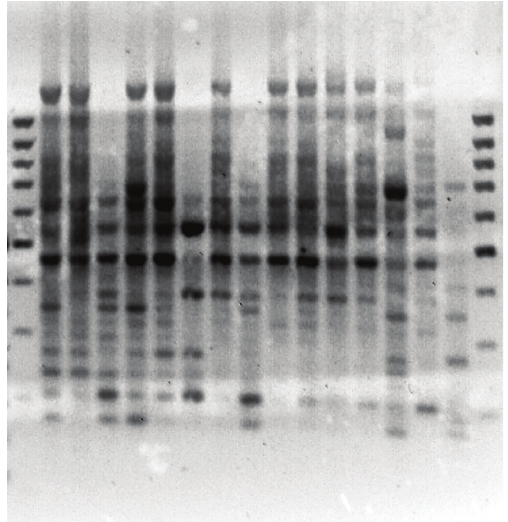
Figure 3: Amplified PCR product using OPC-08 primer.